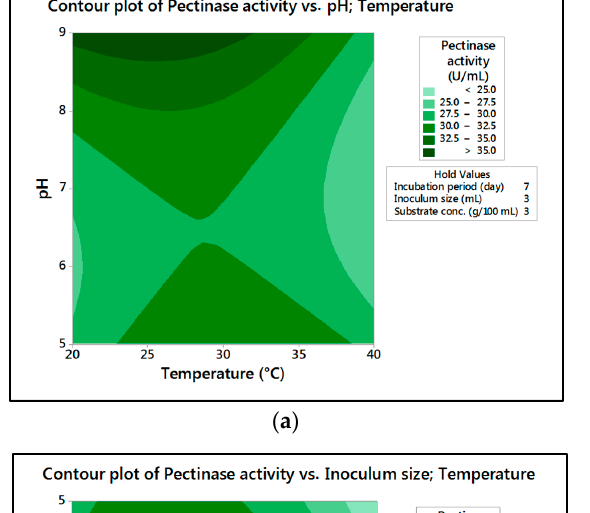
Figure 5. Contour plot showing interactions between independent variables: ( a ) incubation tem- perature with pH; ( b ) incubation temperature with incubation period; ( c ) incubation temperature with inoculum size; ( d ) incubation temperature with substrate concentration; ( e ) pH with incuba- tion period; ( f ) pH with inoculum size; ( g ) pH with substrate concentration; ( h ) incubation period with inoculum size; ( i ) incubation period with substrate concentration; ( j ) inoculum size with sub- strate concentration for pectinase activity produced by M. circinelloides .